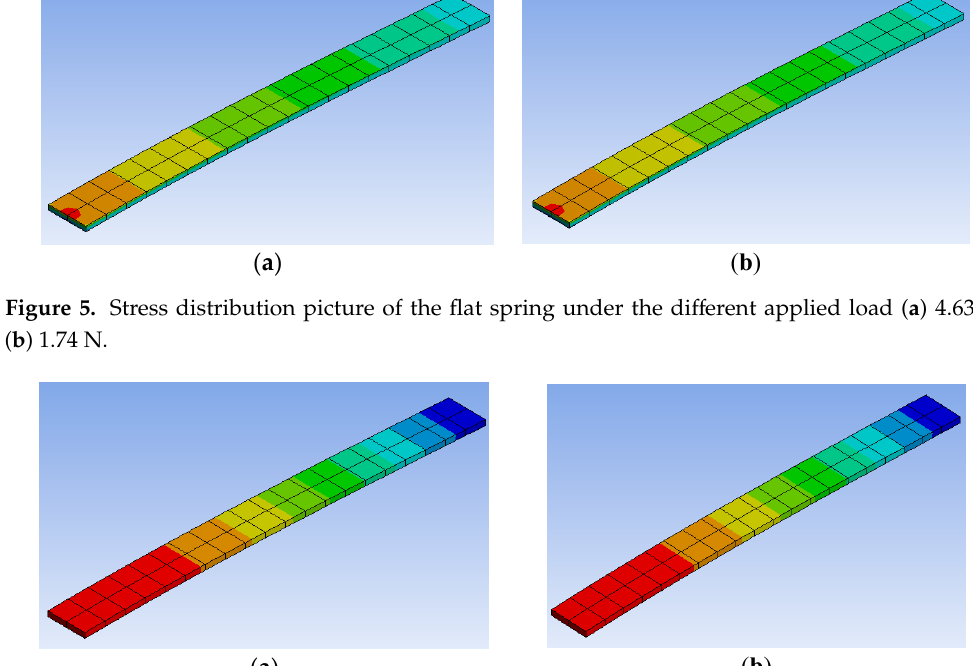
Table 2. Comparison of the stresses and deformation results of the static stress analysis and FEA simulation.